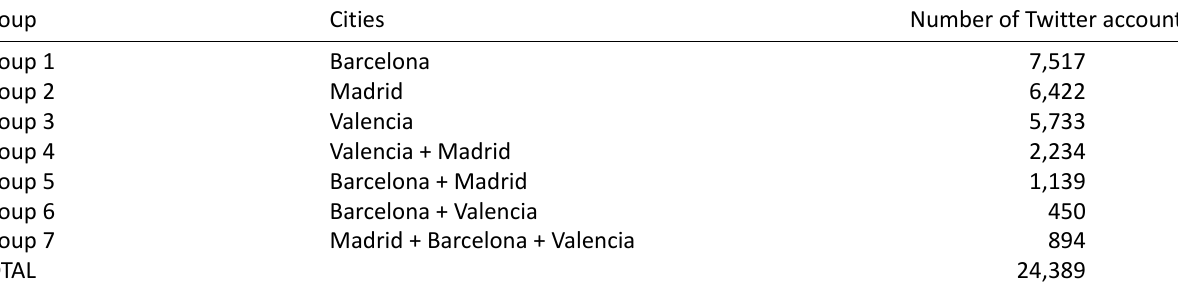
Table 1. Groups of accounts according to their degree of influence in the different sample cities.